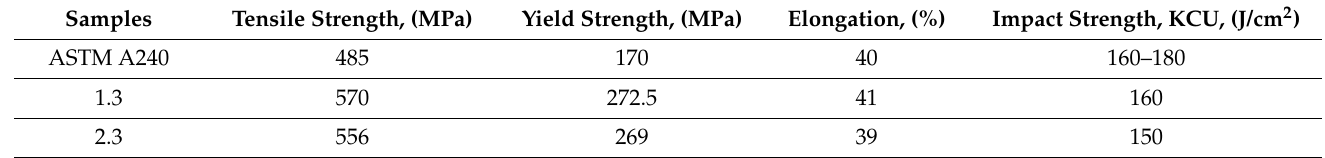
Table 4. Mechanical